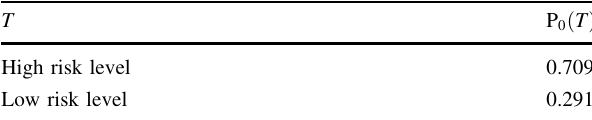
Table 8 Conditional probability distribution at high and low risk levels